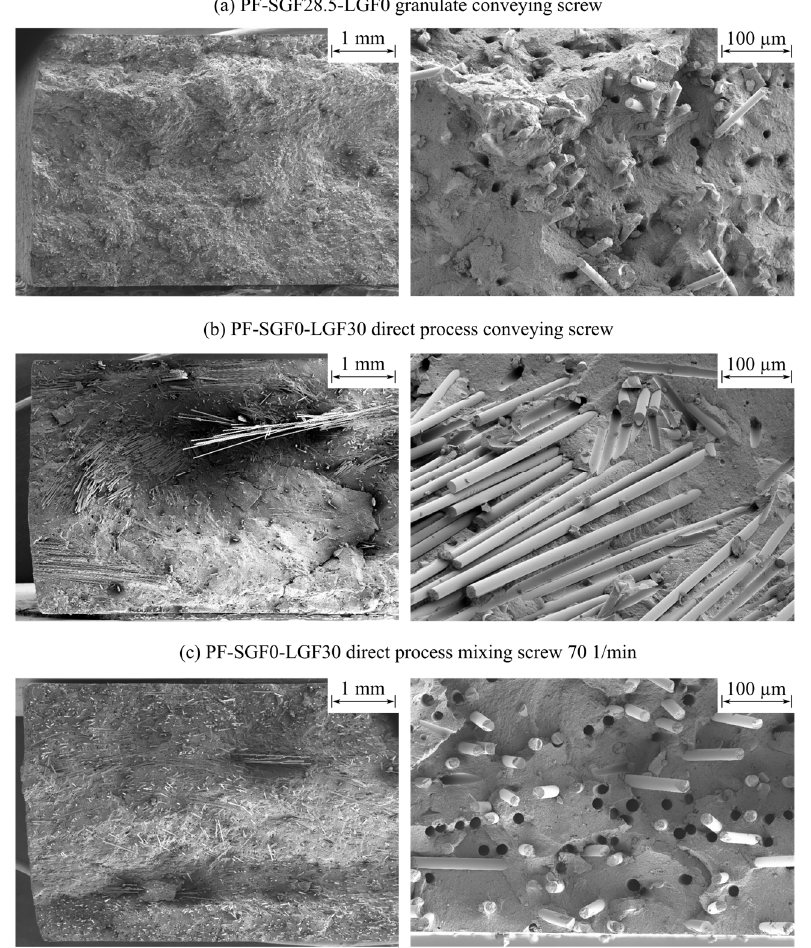
Figure 13. SEM for SGF granulate and LGF direct process mechanical testing specimens.